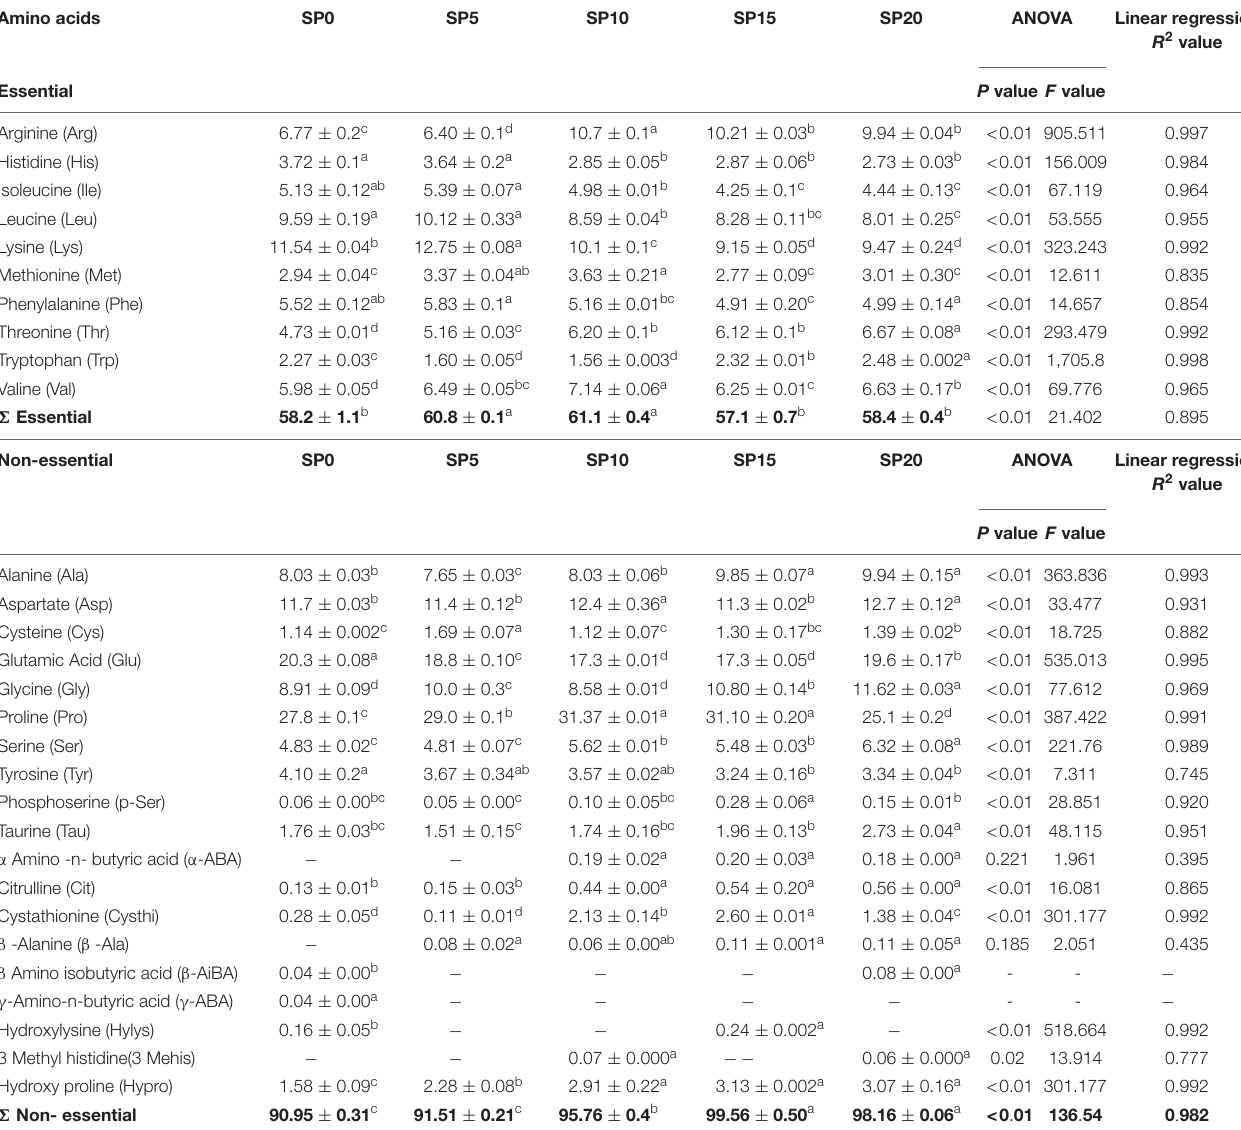
TABLE 4 | Amino acid compositions (g/kg, wet weight) of five different diets-fed Cyprinus carpio . Amino